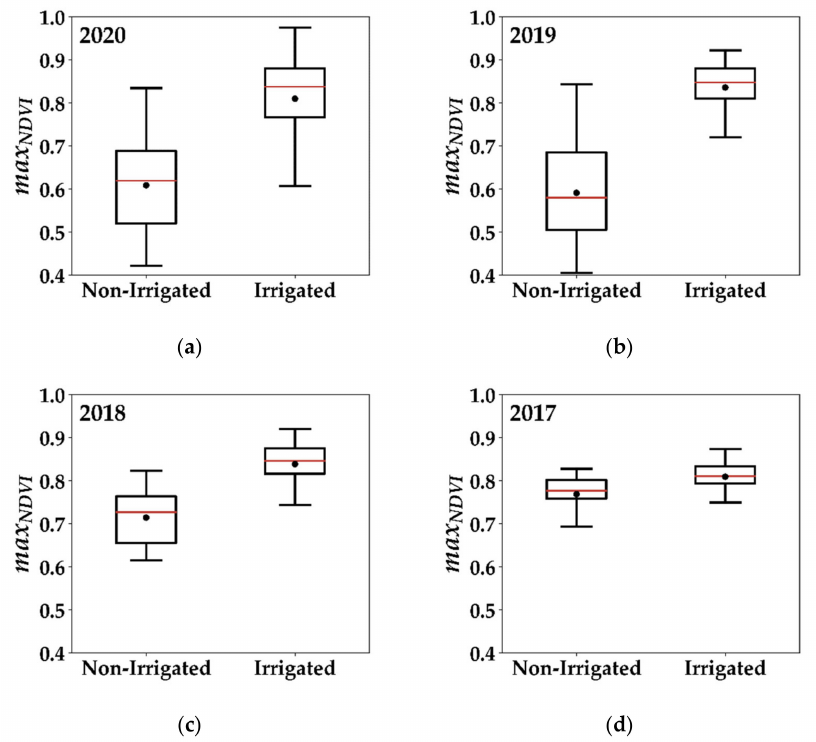
Figure 6. Boxplots of the distribution of maximum NDVI values ( max NDVI ) for in situ irrigated and non-irrigated plots in ( a ) 2020, ( b ) 2019, ( c ) 2018, and ( d ) 2017. The red line in each box represents the median value while the black dot shows the mean value. The number of the irrigated and non-irrigated plots for each year corresponds to the number of in situ plots presented in Table 1 of Section